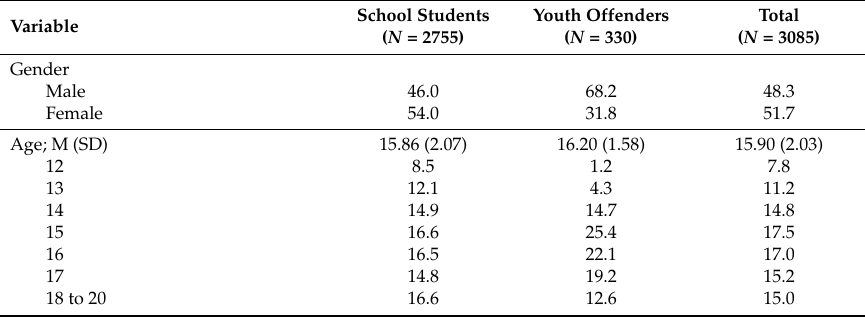
Table 1. Sample characteristics